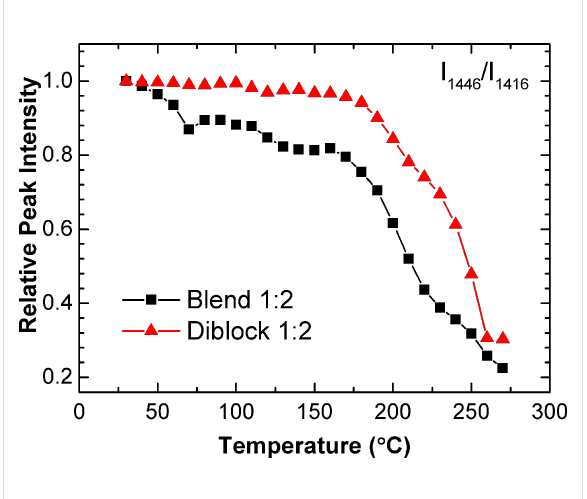
Figure 7: Influence of temperature on the relative Raman scattering in- tensities of the P3OT (1446 cm − 1 ) and F-P3OT (1416 cm − 1 ) C=C bond stretching modes. The block copolymer appears to have a constant relative intensity until ca. 175 ºC, while the blend appears less stable, showing decay almost immediately upon